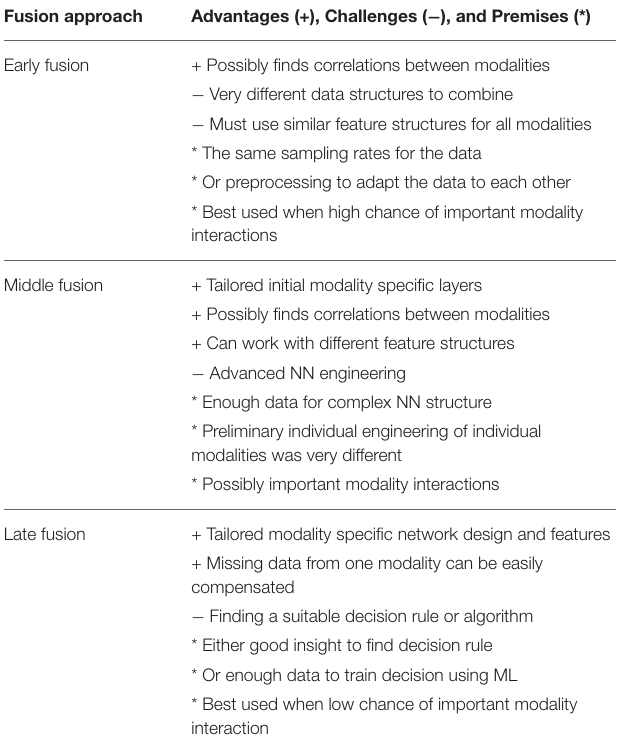
TABLE 4 | Summary of the advantages, challenges, and premises for each fusion